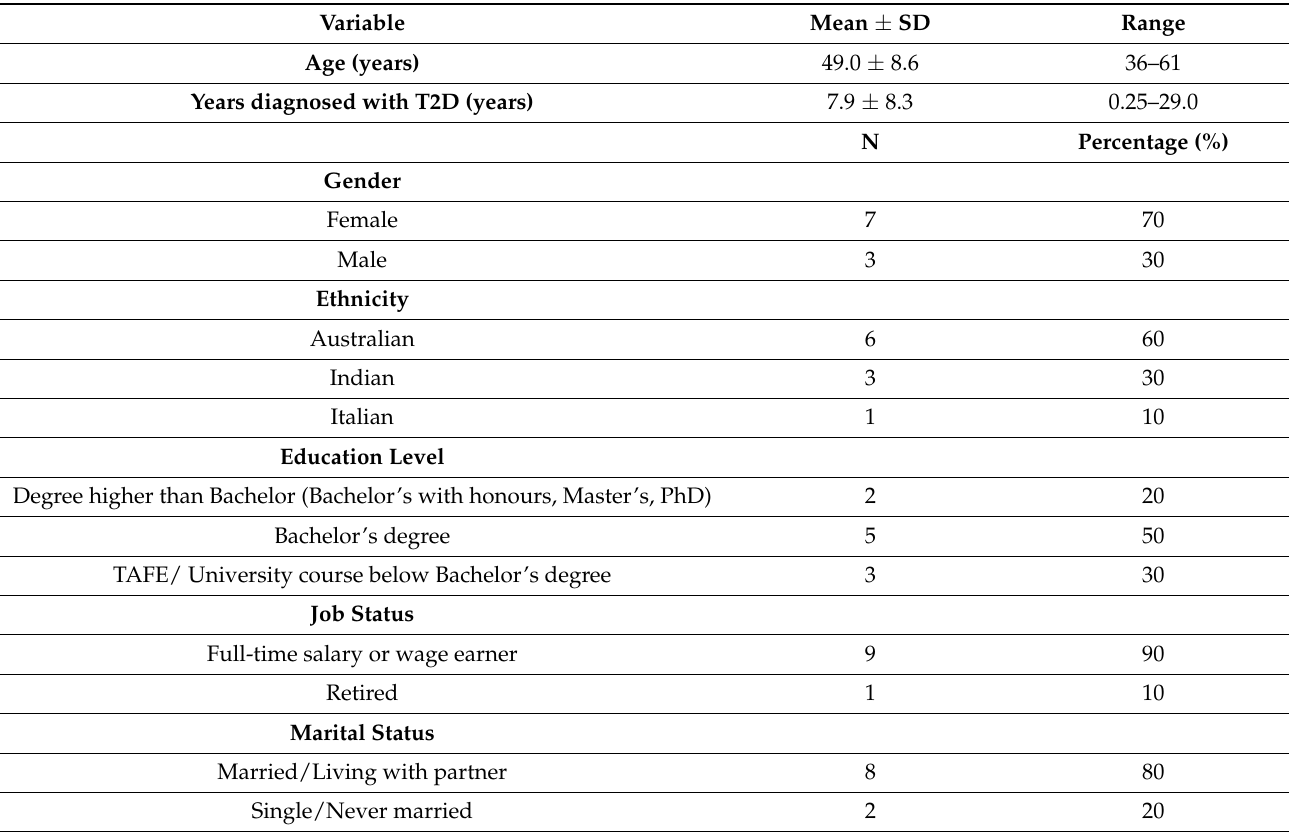
Table 2. Demographic information of study